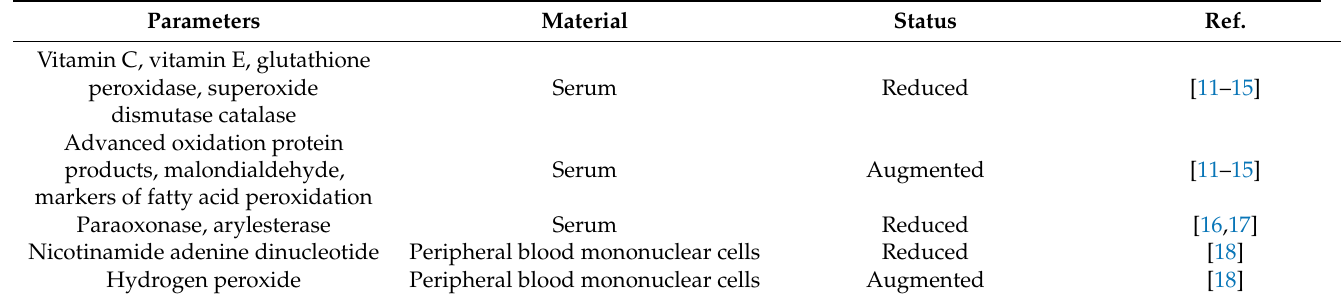
Table 1. Alteration of the redox mechanisms found in patients with multiple